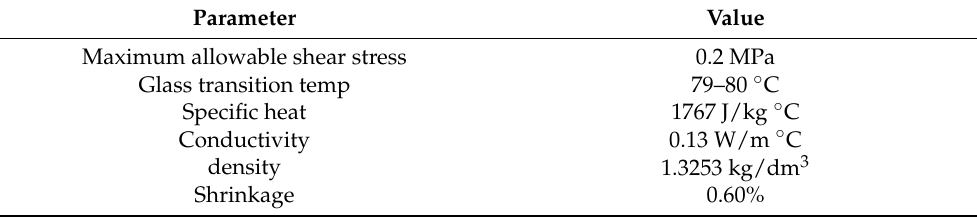
Table 1. Properties of Benvic IR705 [34].